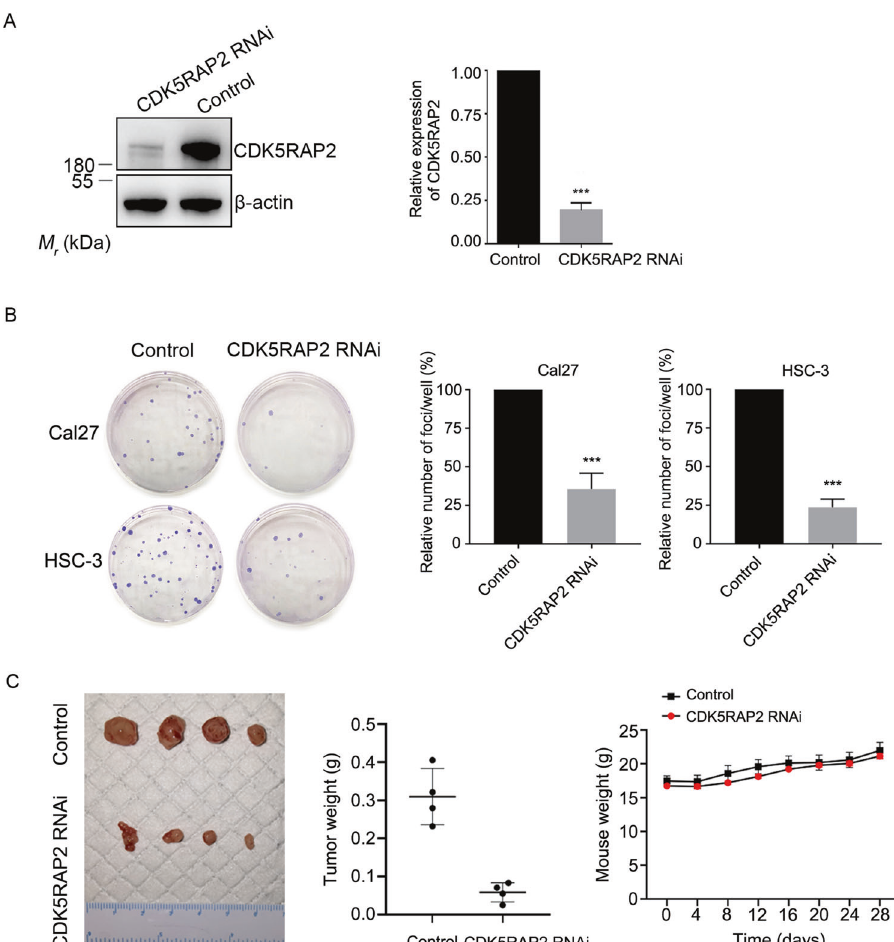
indicated antibodies. B Colony-formation assay was performed using control and stable CDK5RAP2-knockdown cells. Colonies in each well were counted. C shRNA-carrying lines of Cal27 cells were injected subcutaneously into nude mice. The image shows isolated tumors. Mice were weighed every 4 days after injection, and the isolated tumors were weighed. Data are presented as means ± SD; *** P < 0.001, two-tailed Student ’ s t